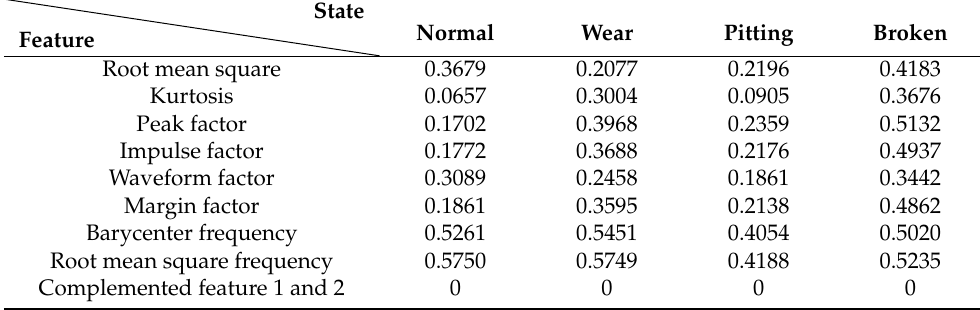
Table 4. Partial normalized